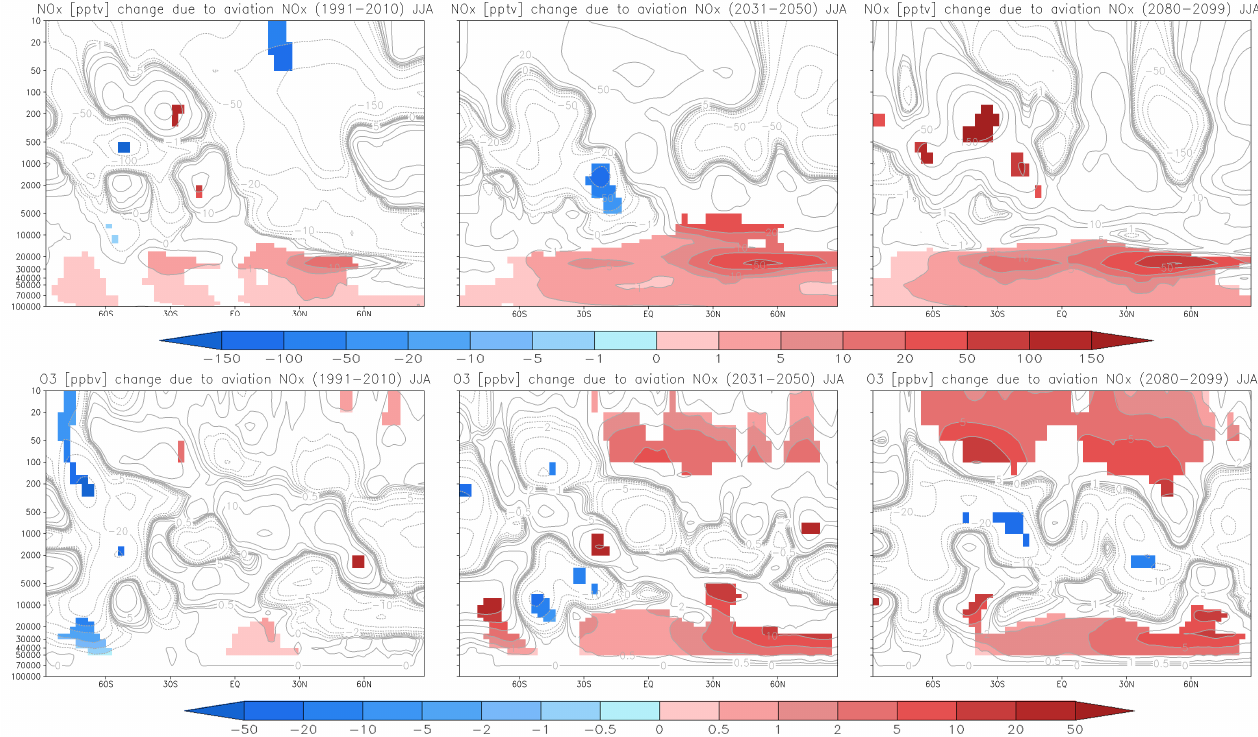
Fig. 8. The June–July–August impact of aircraft NO x emissions on the zonally averaged NO x (pptv, upper row) and O 3 (ppbv, bottom row) distributions for 1991–2010 (left), 2031–2050 (middle) and 2080-2099 (right). The shaded areas show significant changes at the 95% level of confidence. The vertical axis corresponds to pressure in